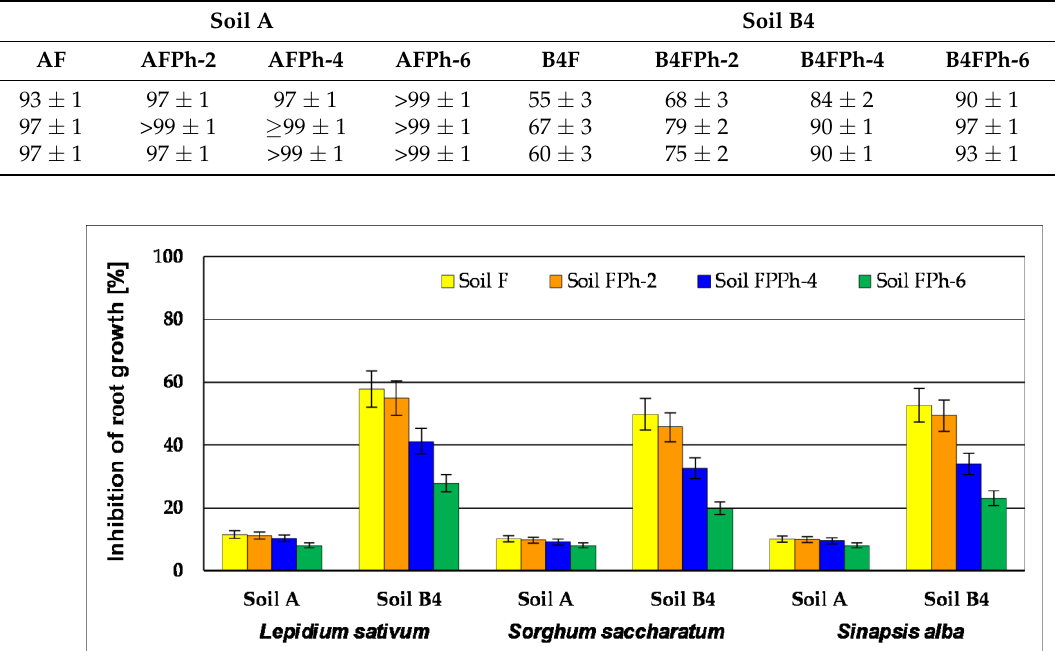
Table 3. Comparison of the amount of germinated seeds ( Lepidium sativum , Sinapis alba , Sorghum saccharatum ) in the Phytotoxkit TM test during phytoremediation with Melilotus officinalis enhanced by fertilization of soils A and B4 (repetitions number n = 3, p < 0.05).